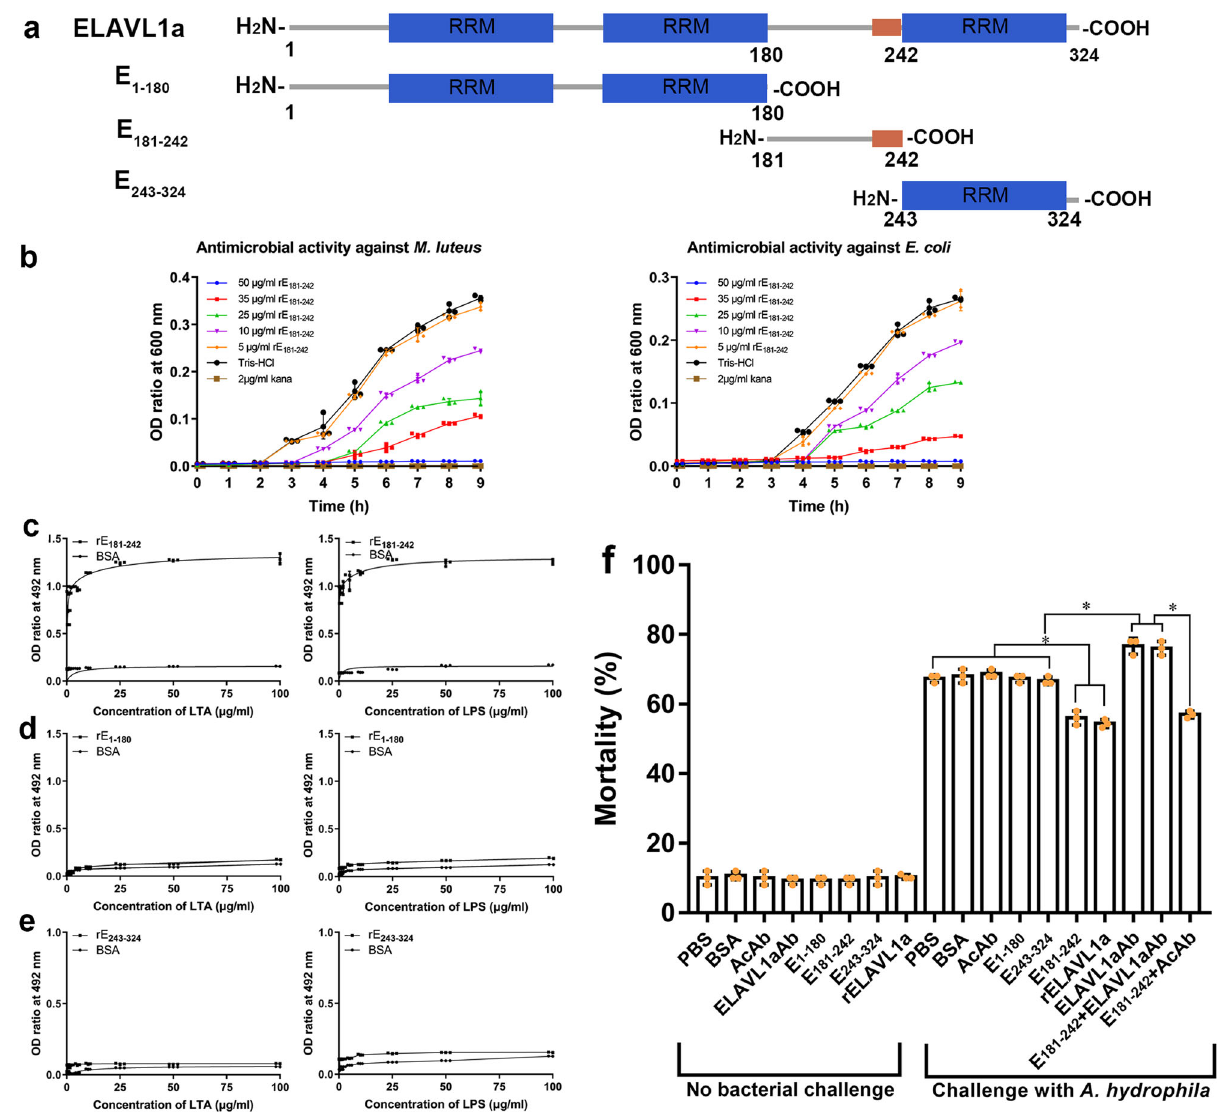
Fig. 7 Diagram showing zebra fi sh ELAVL1a truncation and their antibacterial activities and binding to LPS and LTA. a Diagram showing zebra fi sh ELAVL1a truncation. b Antibacterial activity of rE 181 – 242 against M. luteus and E. coli . c , d , e Interaction of rE 181 – 242 ( c ), rE 1 – 180 ( d ) and rE 243 – 324 ( e ) with LTA and LPS revealed by ELISA. f The in vivo bioactivity of rE 1 – 180 , rE 181 – 242 , and rE 243 – 324 . The early (8-cell stage) embryos were fi rst microinjected with PBS, BSA, anti- β -actin antibody (AcAb), anti ELAVL1a antibody (ELAVL1aAb), rE 1 – 180 , rE 181 – 242, rE 243 – 324 and rELAVL1a, then challenged by injection with live A. hydrophila . The development of the embryos was observed and the cumulative mortality rate was calculated at 24 h after injection. All data were expressed as mean values ± S.D. ( n = 3). The data are from three independent experiments performed in triplicate. The bars represent the mean ± SD. The signi fi cance of the difference was determined by one-way ANOVA. * p < 0.05. AcAb, anti- β -actin antibody; ELAVL1aAb, mouse anti-ELAVL1a